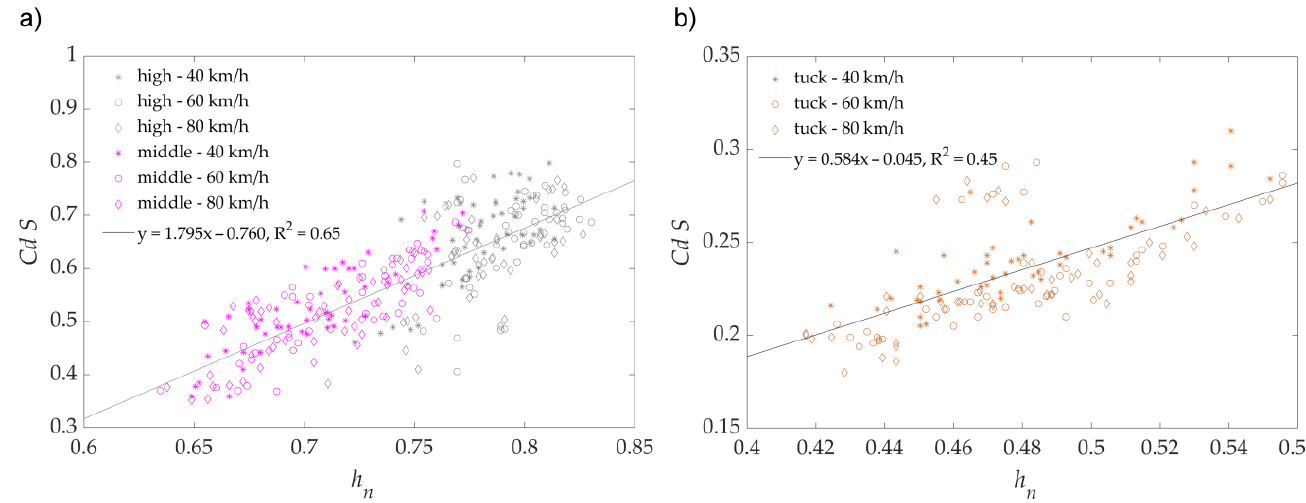
Figure 2. Linear regression model with R 2 values for the product of the coefficient of aerodynamic drag and cross-sectional area (C d ∙S) as a function of normalized shoulder height (h n ) ( a ) in the high (violet) and middle positions (grey)); ( b ) in the downhill (tuck) position (brown).